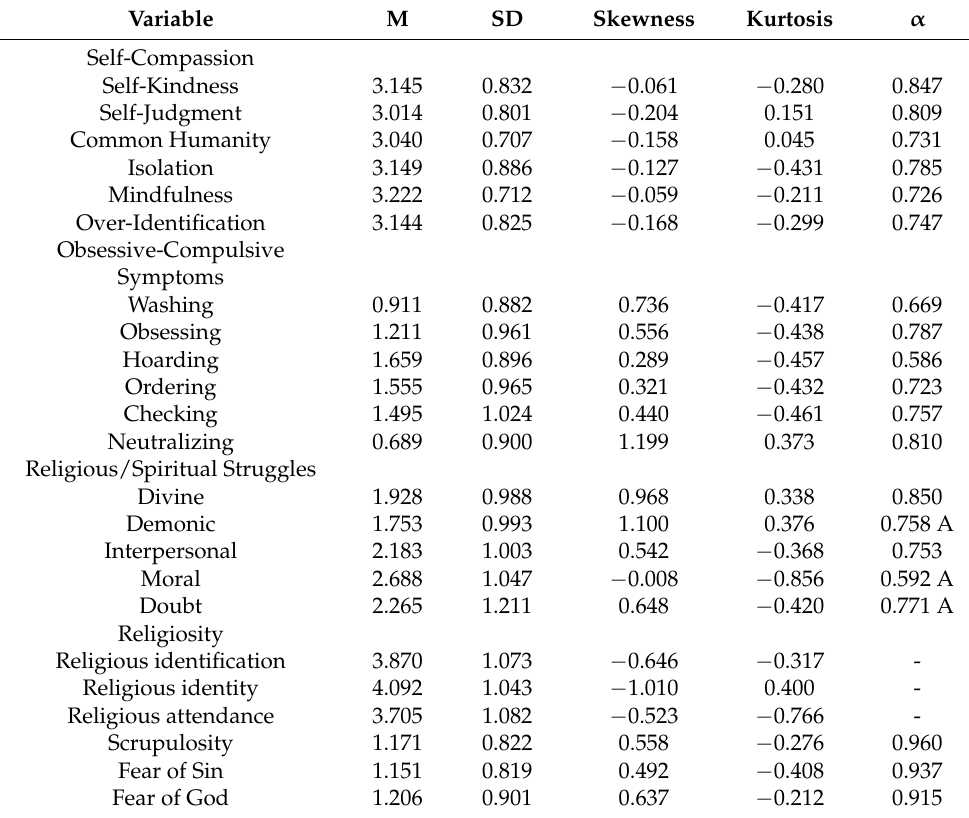
Table 1. Descriptive statistics for the study